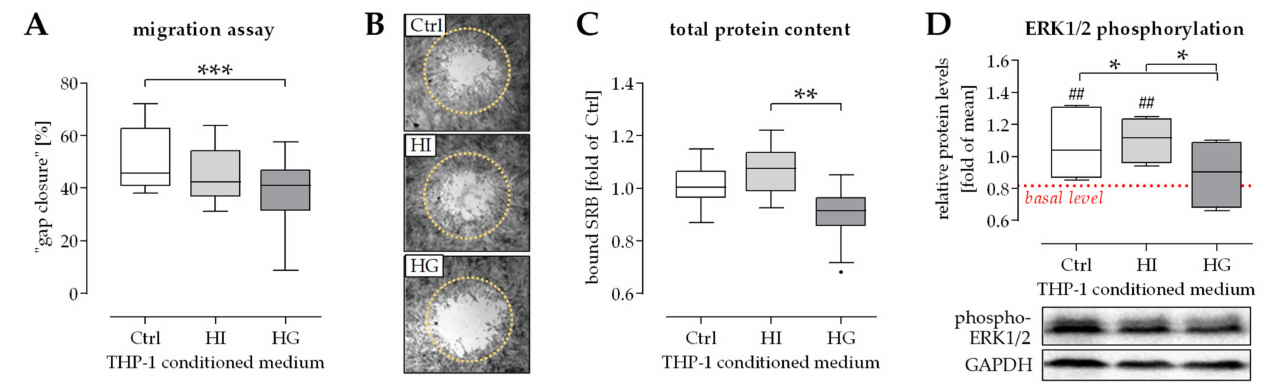
Figure 6. Pre-/diabetic conditions impair THP-1 cells-favored migration of SCP-1 cells. THP-1 cells were cultured under normoglycemic (Ctrl), hyperinsulinemic (HI), or hyperglycemic (HG) conditions for 48 h to obtain THP-1 cell conditioned media. ( A ) Migration of SCP-1 cells in the presence of these THP-1 cell conditioned media was determined using the Oris TM cell migration assay (Platypus Technologies, Madison, WI, USA). ( B ) Representative image of the cell migration assay after 45 h of incubation. The dotted circle marks the initial detection zone (Original magnification 2x) ( C ) Total protein content was determined by SRB staining. ( D ) Levels of phosphorylated ERK1/2 were determined by Western blot in SCP-1 cells exposed to THP-1 cell conditioned media. GAPDH was used for normalization. Signal intensities were quantified using the ImageJ software. Data are presented as box plots. N = 4 and n = 4. Data were compared by non-parametric Kruskal-Wallis test, followed by Dunn’s multiple comparison test. * p < 0.05; ** p < 0.01 and *** p < 0.0001 as indicated. ## p < 0.01 as compared to the respective control sample without THP-1 conditioned medium (basal